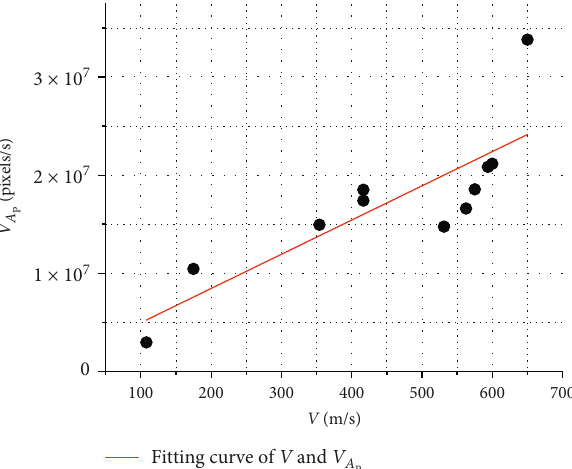
Figure 7: Relationship between V and V under SHPB